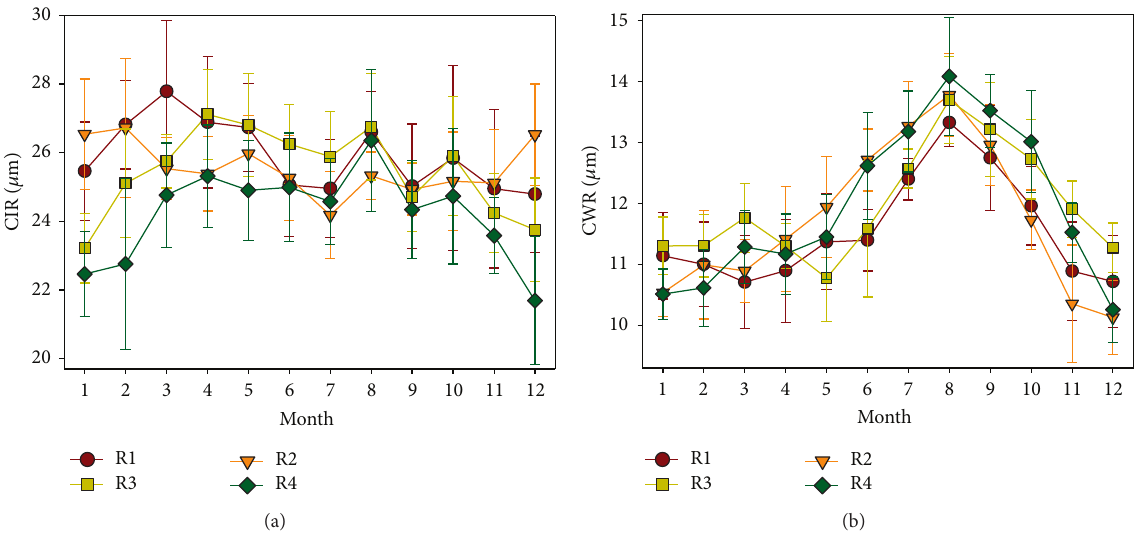
Figure 3: Same as Figure 2 but for (a) CIR and (b)